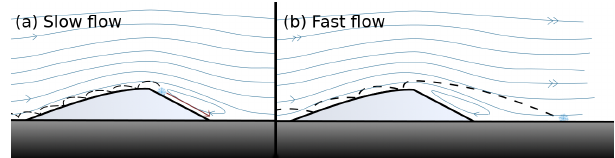
Figure 14. Conceptual model of grain transport over a dune in (a) slow-moving air and (b) fast-moving air. Solid blue lines are time-averaged streamlines, with boundary-layer fluctuations omit- ted for clarity. Dashed black line shows a grain trajectory. The arrow in panel (a) shows an avalanche